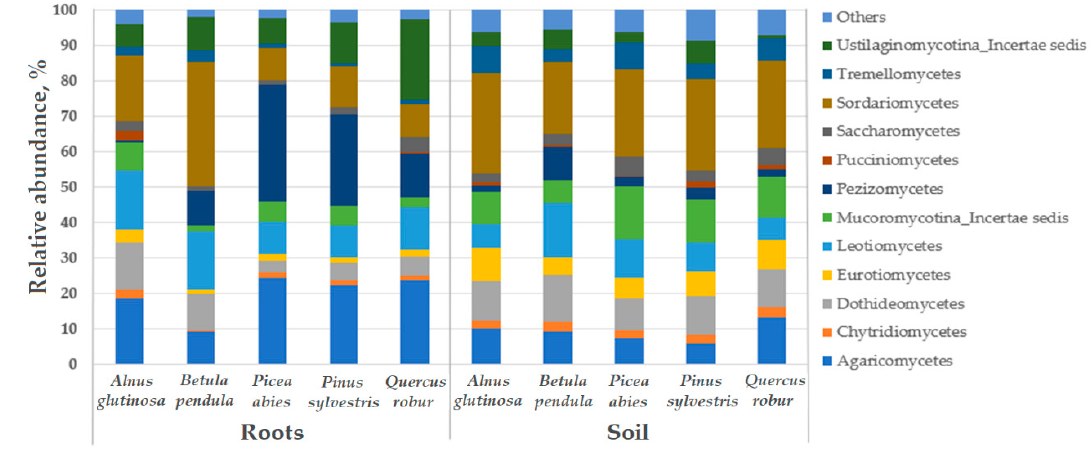
Figure 5. Relative abundance of the fungal classes in the roots and soil of the different tree species, and the other fungal classes that presented with a relative abundance of <1%. The data from the different forest nurseries are combined.